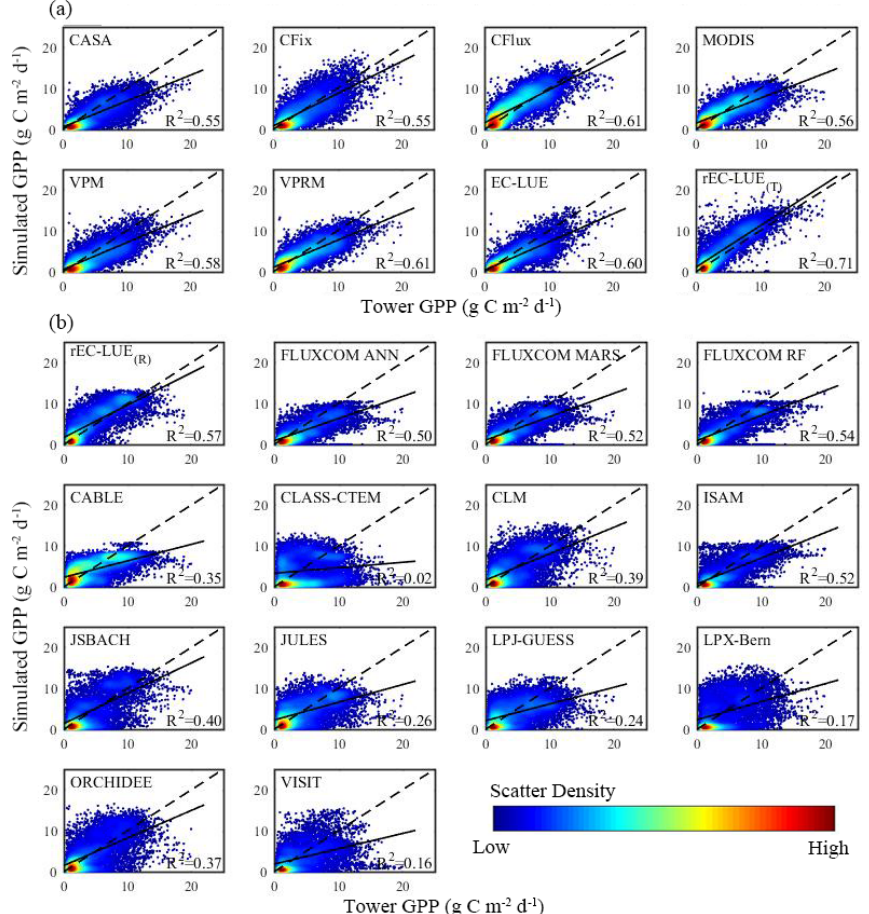
Figure 4. Comparisons between estimated GPP based on EC measurements and GPP simulations in growing season (defined as temperature larger than 0 ◦ ) by the various models (including LUE models, machine learning models, and process-based biophysical models in TRENDY) at a monthly scale. The comparison of GPP simulations was simulated using (a) tower-derived meteorology data and (b) global reanalysis meteorology data, respectively (see Sect. 2.4). rEC-LUE ( T ) and rEC-LUE ( R ) indicate the simulations of the revised EC-LUE model derived from tower-derived meteorology data and global reanalysis meteorology data, respectively.